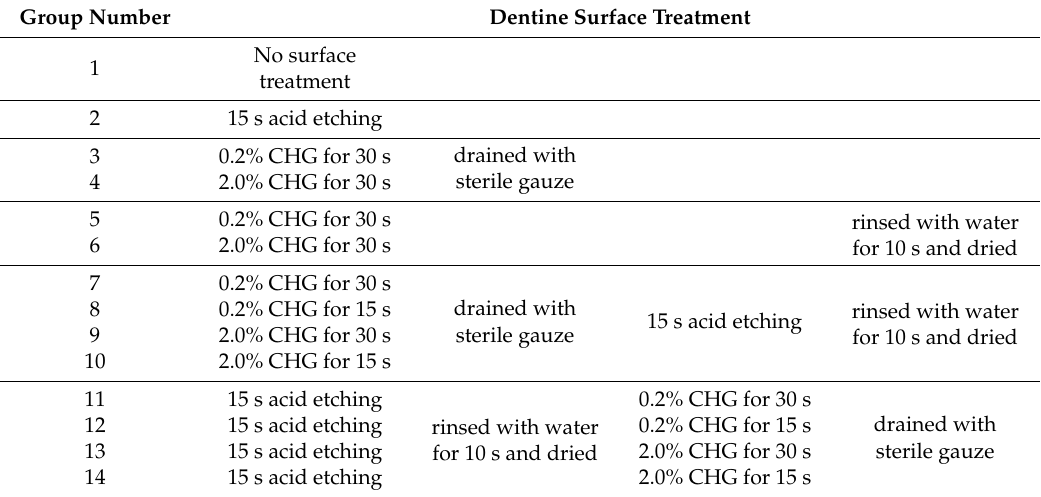
Table 1. Dentine surface treatment (study